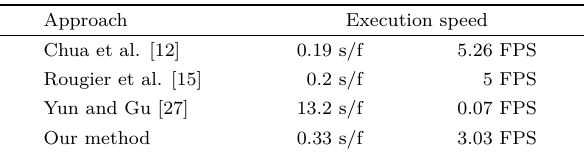
Table 9 Processing time for fall detection